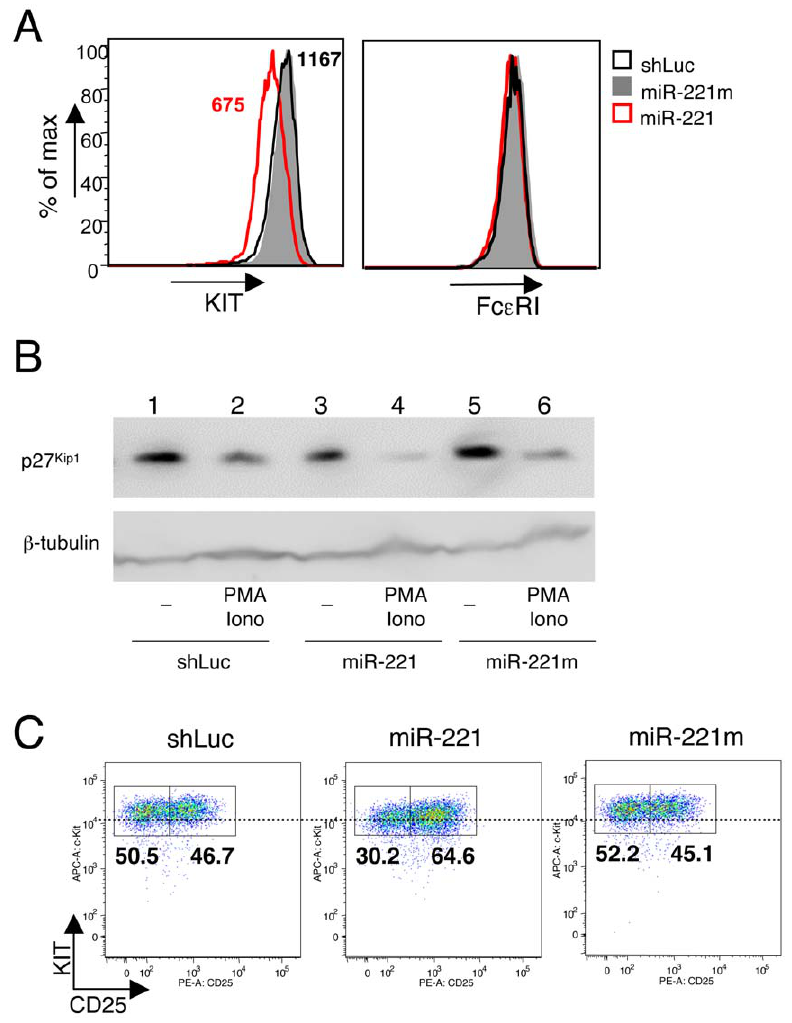
Figure 4. MiR-221 primary and secondary targets are altered also at protein level. A ) Differentiated BMMCs were either left untransduced or were transduced with the indicated vectors. After selection with puromycin, surface expression of KIT ( left ) and Fc e RI ( right ) was assessed by FACS. The mean fluorescence intensity (MFI) for KIT expression in miR-221- (red) and shLuc- (black) expressing cells is also indicated. B ) Differentiated BMMCs as in A) were either left untreated or were stimulated with 20nM PMA and 1 m M ionomycin for 24h prior lysis and Western blot analysis of p27 Kip1 expression. b -tubulin was used as loading control. C ) BMMCs as in A) were stained and FACS-analyzed to assess surface expression of KIT and CD25. The horizontal dotted line was added as a reference to appreciate the expected KIT dowregulation in miR-221 expressing cells.